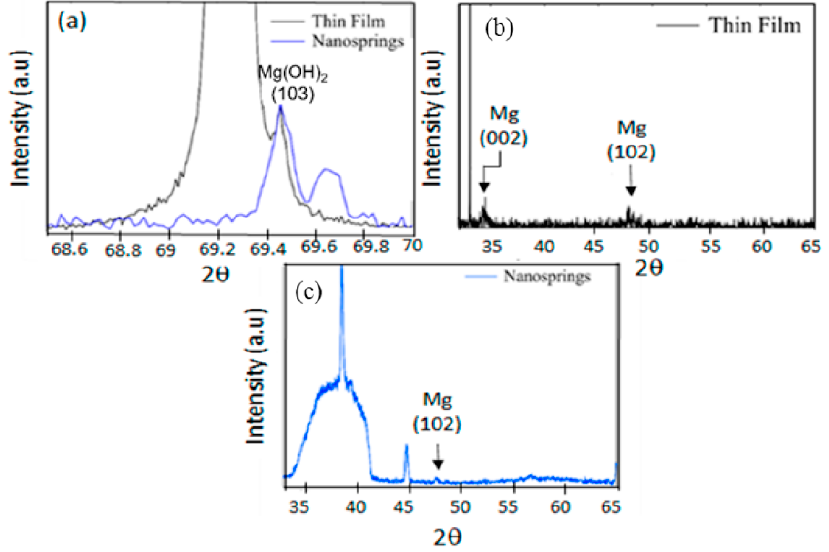
Figure 4. HRXRD and PXRD patterns of Mg on Si(100) wafers and nanosprings, respectively, where ( a ) shows a scan from 68.5 to 70 degrees with a sharp Mg(Oh) 2 peak present and ( b ) a broader scan from 30 to 65 degrees where Mg(002) and Mg(102) orientations are present for the thin film sample and ( c ) Mg(102) is also observed in the PXRD spectrum of the Mg-coated nanosprings.